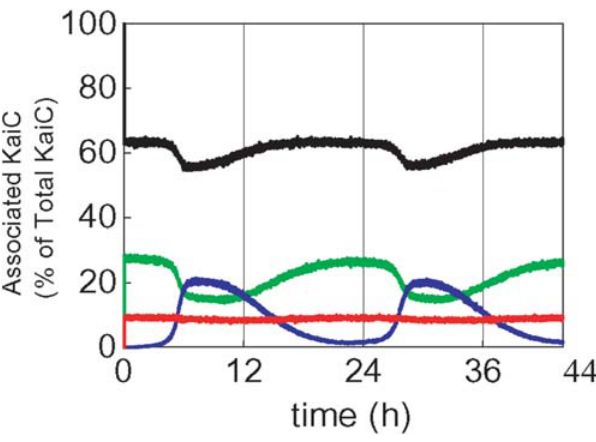
Figure 6. Dynamics of protein association as shown by the amount of the KaiC-KaiA complex (P AC , green), the KaiC-KaiB complex (P BC , blue), the KaiC-KaiA-KaiB and KaiC-KaiB-KaiA complexes (P ABC , red), and the free KaiC (P free , black). The amounts are expressed as percentage of the total number of KaiC hexamers.